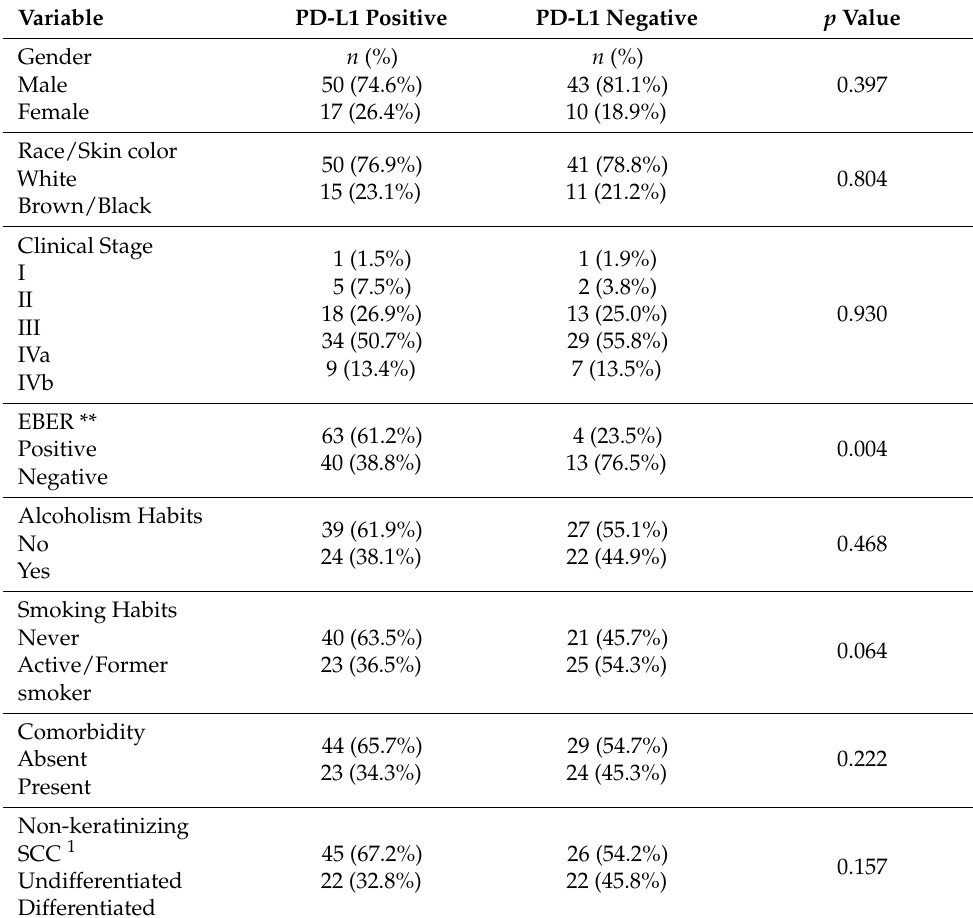
Table 4. Univariate analysis for PD-L1 * positivity.